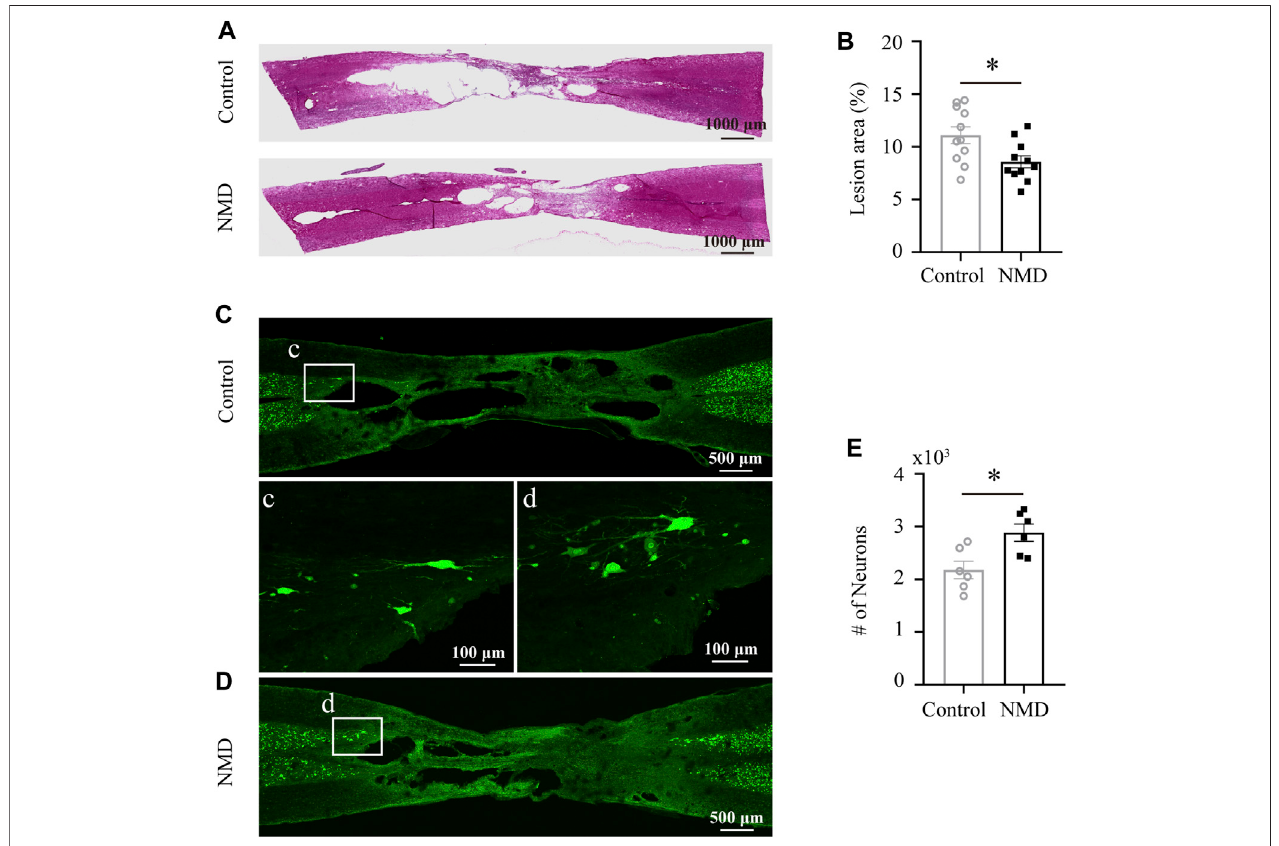
FIGURE 4 | Long-term administration of NMD reduces the lesion area and promotes sparing of perilesional neurons. (A) Injured spinal cord stained with HE showing the epicenter of the lesion at 12 weeks postinjury. (B) The mean lesion area (%) was quanti fi ed by considering the total volume of the spinal cord. NMD-treated ratsshowedasigni fi cantlyreducedlesionarearelativetocontrols( n (cid:1) 11ratsineachgroup).Unpairedt-test,t(20) (cid:1) 2.628, p (cid:1) 0.0161. (C – D) Representativeimagesof horizontalsections ofinjuredspinalcord at12 weekspost-SCI immunostainedwiththeneuronalmarkerNeuN.Theboxed regionineach imageismagni fi ed inthe corresponding panel c, d to show NeuN + neurons. (E) NMD-treated rats showed signi fi cantly higher perilesional neuronal sparing than controls ( n (cid:1) 6 rats in each group). Unpaired t-test, t (10) (cid:1) 3.021, p (cid:1)